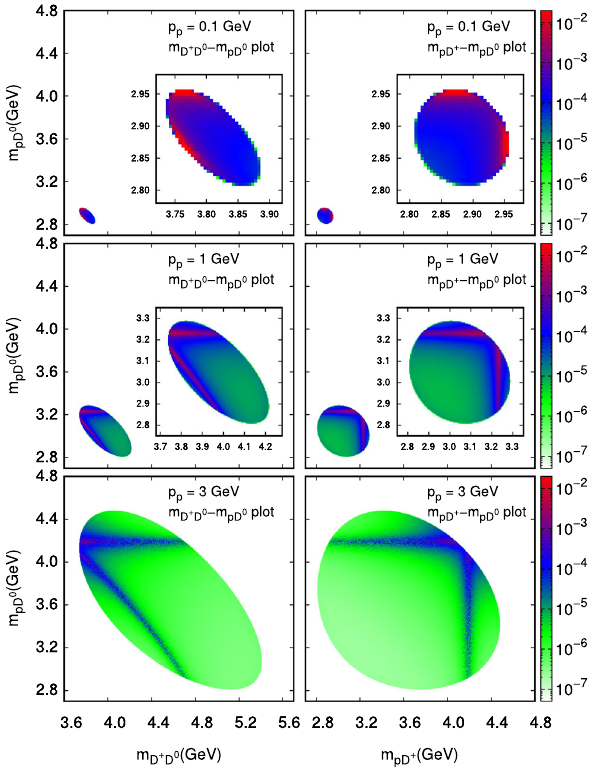
(cid:19) ( k + k ) 2 of the final mesons i i j